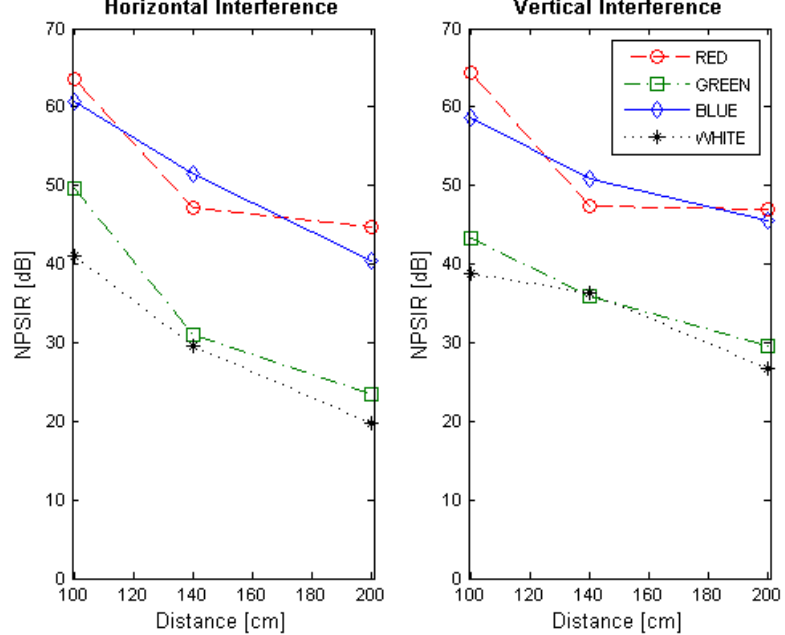
Figure 14. Normalized Power Signal to Interference Ratio for transmitting in green. The left chart presents the interference of close emitters located on the same horizontal line. Right chart shows the interference of the transmitters within the same vertical line.